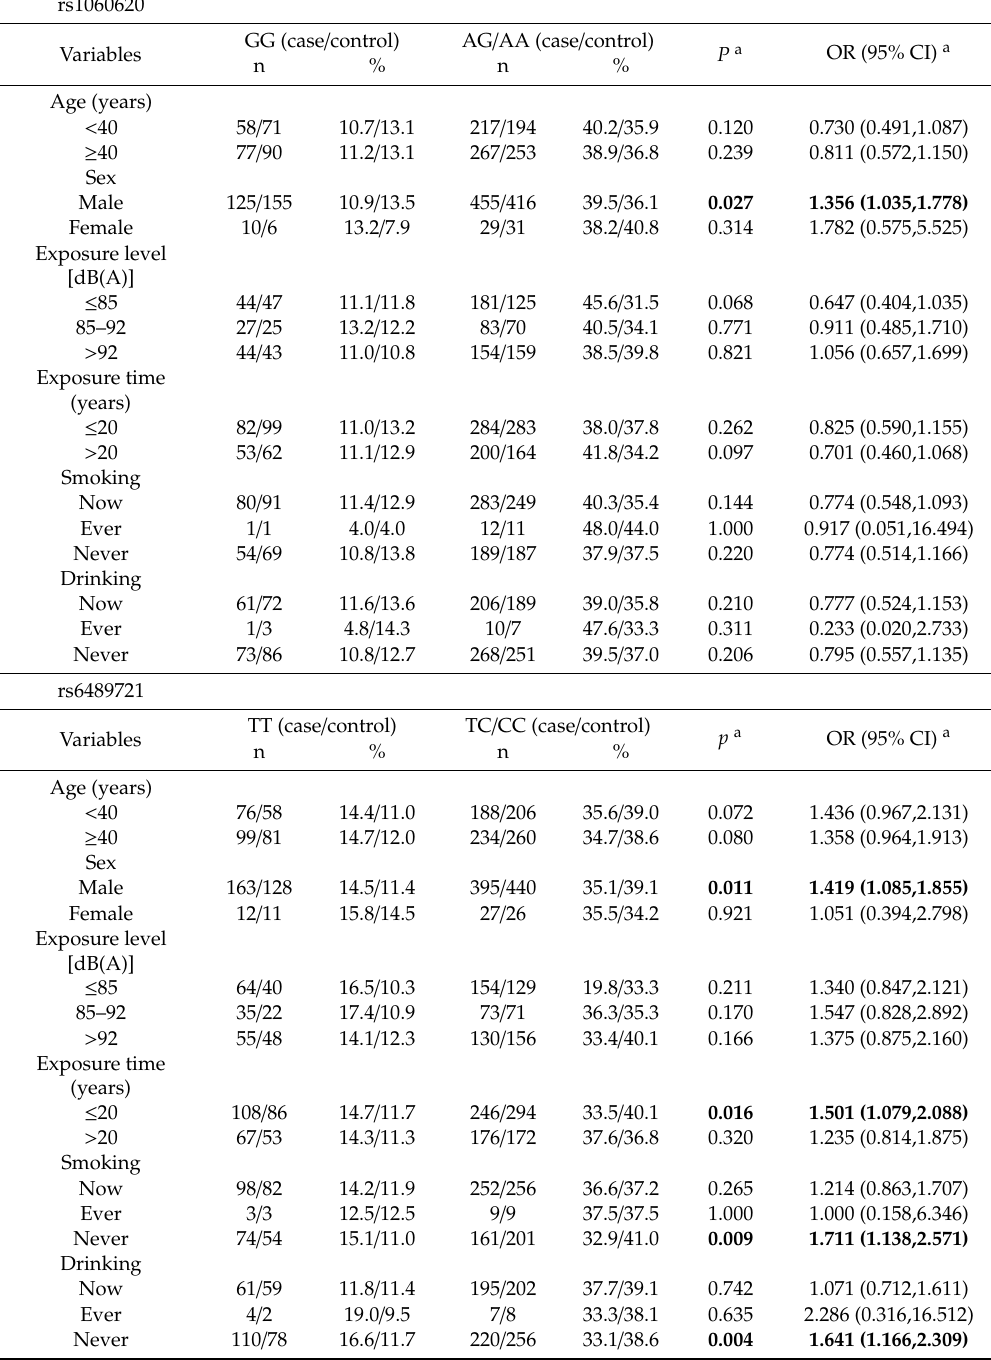
Table 6. Compared with individuals with wild TT genotypes and noise exposure levels ≤ 85 dB(A), individuals with mutant genotypes (TC + CC) and noise exposure levels > 92 dB(A) had a significantly reduced risk of NIHL (OR = 0.495, 95% CI (0.311, 0.790)), indicating an interaction between